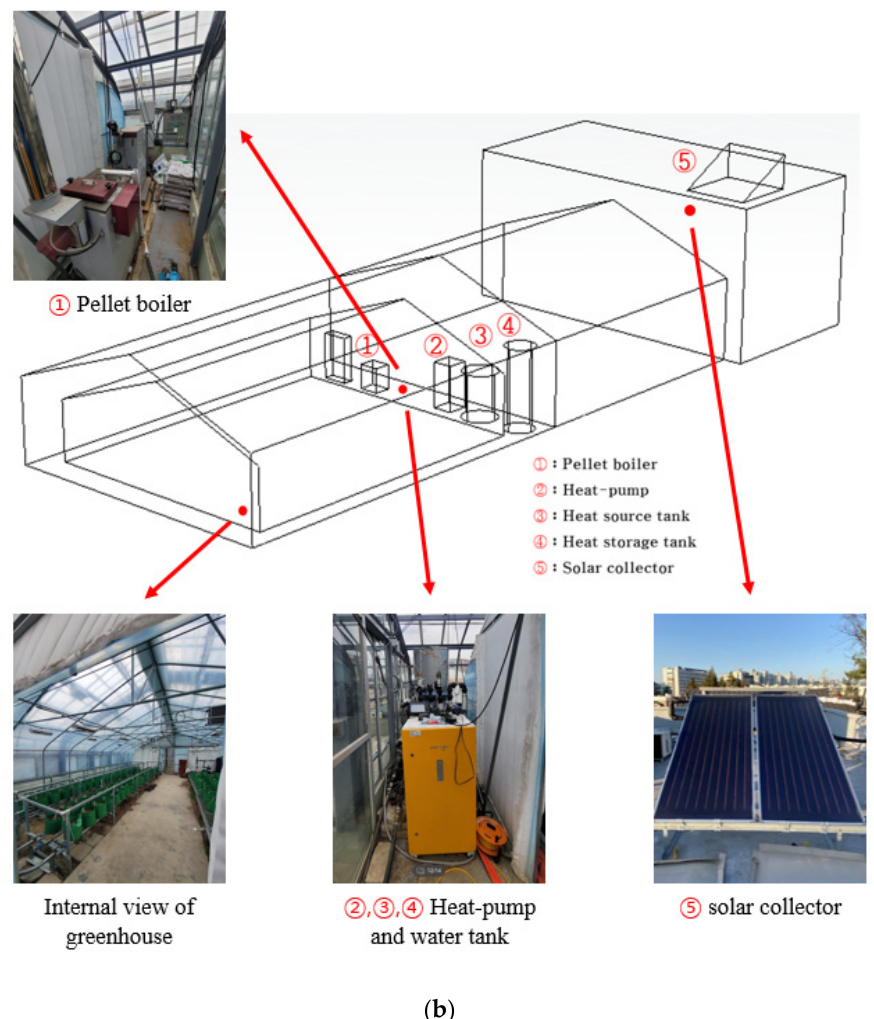
Figure 1. Greenhouse overview. ( a ) Photo of experimental greenhouse, and ( b ) Heating device installation overview.